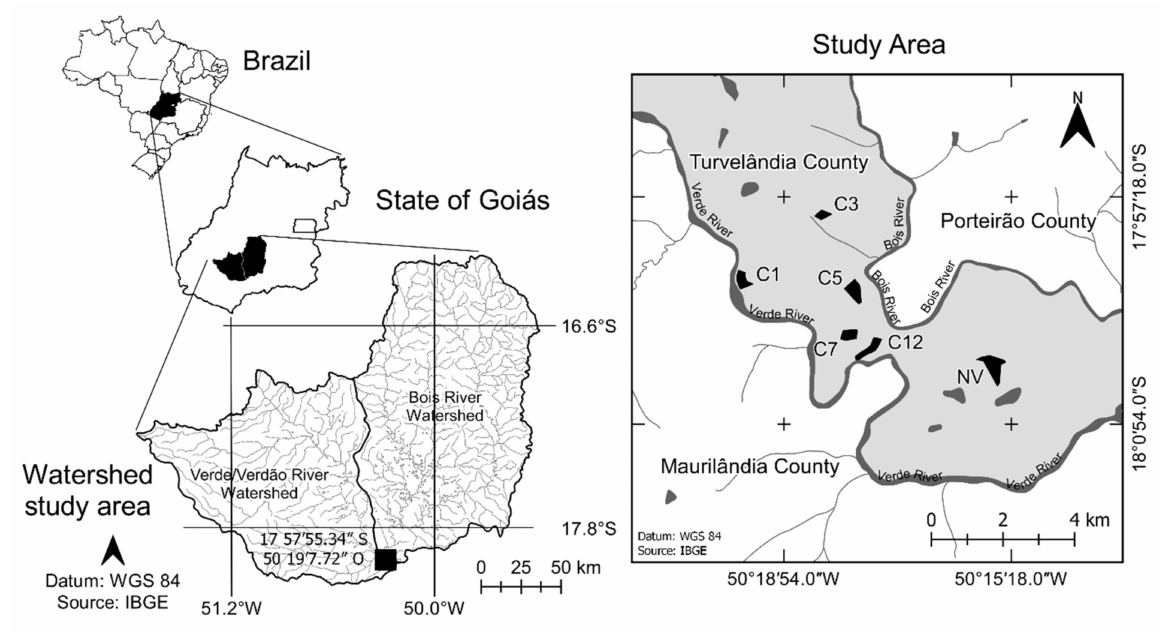
Figure 1. Location of study areas in the Midwest region of Brazil. Table 1. History of use of the areas under Ferralsol in environments of sugarcane production fertigated with vinasse and native vegetation (NV), in the midwest region of